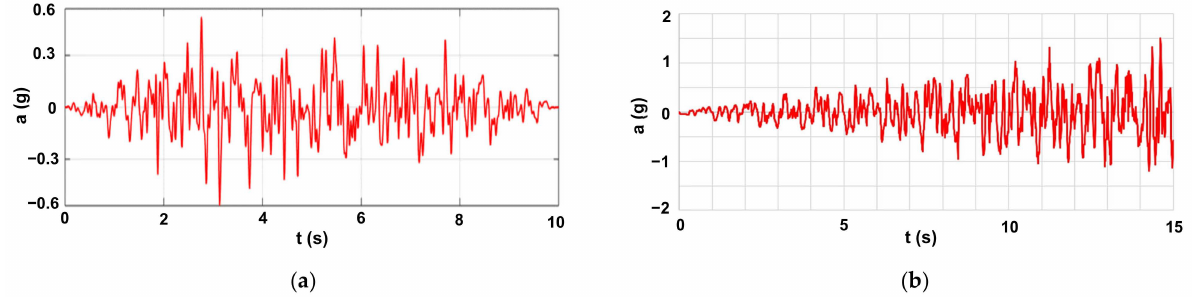
Figure 2. Seismic acceleration time histories: ( a ) design spectrum compatible generated acceleration time history; ( b ) intensifying dynamic excitation produced based on an